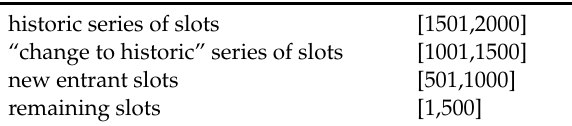
Table 1. Range of standardized